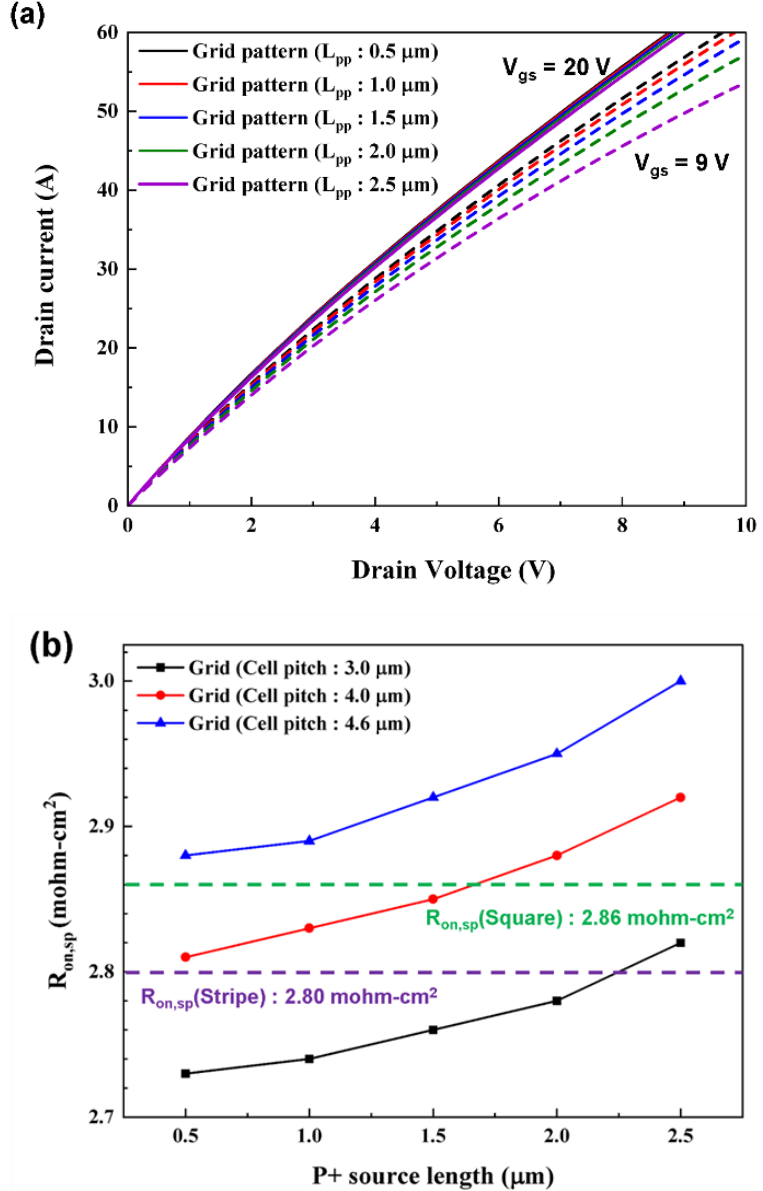
Figure 4. ( a ) Output characteristics of grid pattern with L pp of 0.5 to 2.5 µ m with 0.5 µ m steps; ( b ) specific on-resistance with square, stripe, and grid patterns with cell pitches of 3.0 µ m, 4.0 µ m, and 4.6 µ m.